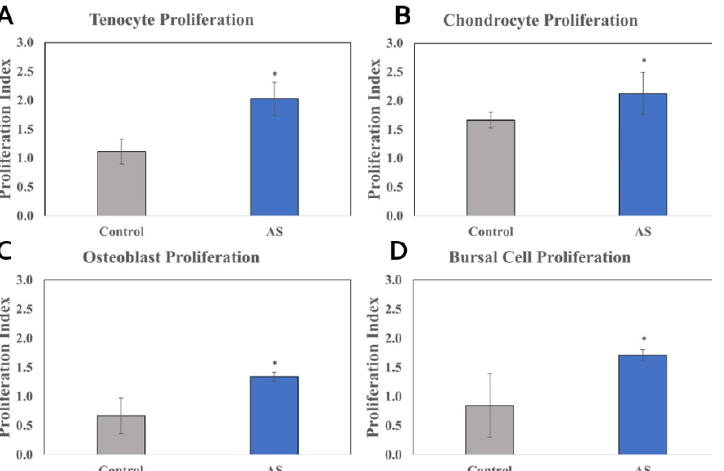
Figure 1. Cellular proliferation of cell lines treated with activated serum vs. control. XTT (sodium 3 ′‐ [1 ‐ (phenylaminocarbonyl) ‐ 3,4 ‐ tetrazolium] ‐ bis(4 ‐ methoxy6 ‐ nitro) benzene sulfonic acid hydrate) assay analyzed the proliferation rate by measuring the absorbance of formazan salt at 450 nm. The absorbance value detected by the plate reader functioned as a direct correlate to the number of actively dividing cells present in the culture. The AS demonstrated higher rates of cellular proliferation compared to control in all cell lines. Tenocytes, chondrocytes, osteoblasts, and subacromial bursal cell lines can be observed above in ( A – D ), respectively. Statistical significance ( p < 0.05) denoted by * (compared to control). AS, Activated Serum.